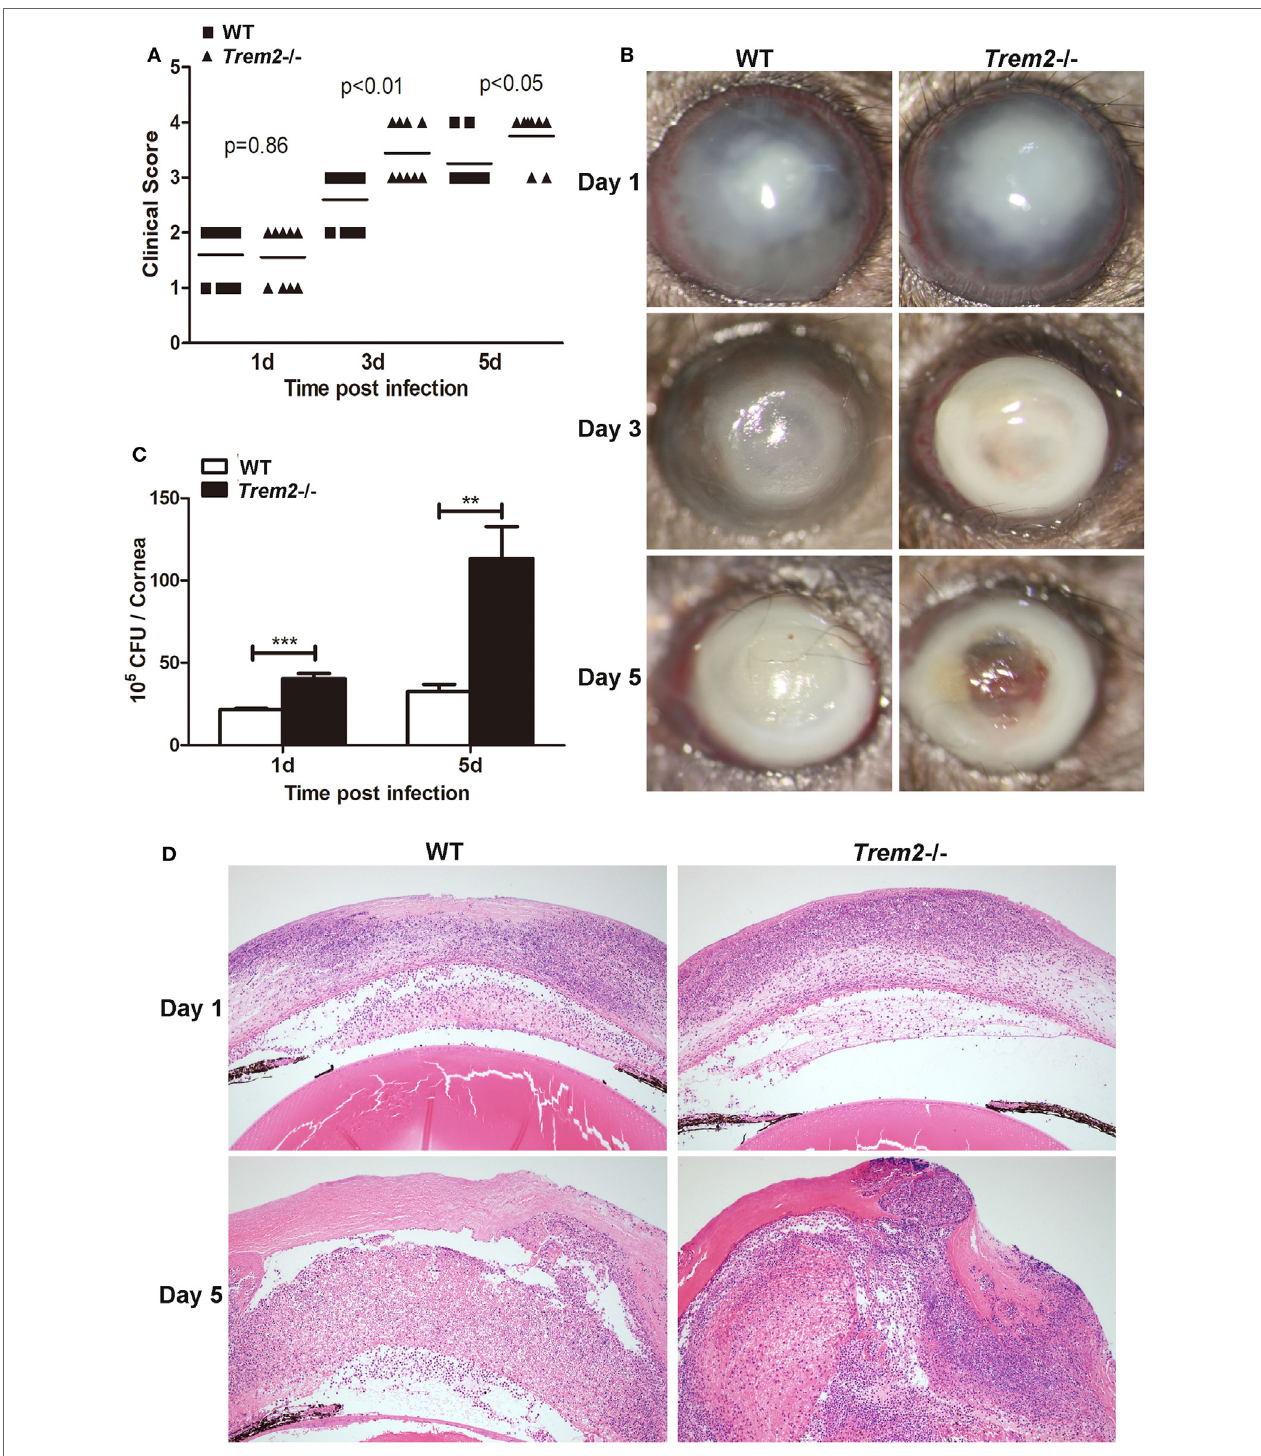
FigUre 1 | Triggering receptors expressed on myeloid cells 2 (TREM-2) promoted host resistance against Pseudomonas aeruginosa keratitis. Trem2 − / − and wild type (WT) C57BL/6 mice were infected with P. aeruginosa . (a) Clinical score was recorded for each cornea at 1, 3, and 5 days after infection. (B) Representative slit-lamp photographs of infected eyes in WT (left) and Trem2 − / − (right) mice were taken 1, 3, and 5 days after infection. (c) Bacterial load in the infected corneas was examined by plate count assay in WT versus Trem2 − / − mice at 1 and 5 days after infection. (D) Hematoxylin and eosin staining was used to examine the histopathology of infected eyes in WT (left) and Trem2 − / − (right) mice at 1 and 5 days after infection. Magnification = 100 × . Data are the mean ± SEM and represent three individual experiments each with 10 mice per group (a,B) or five mice per group (c,D) . * P < 0.05; ** P < 0.01; *** P < 0.001.